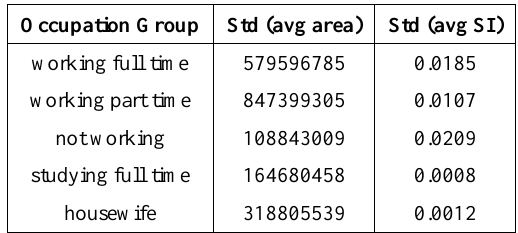
Table 18. Comparison the effect of days of week on users with different